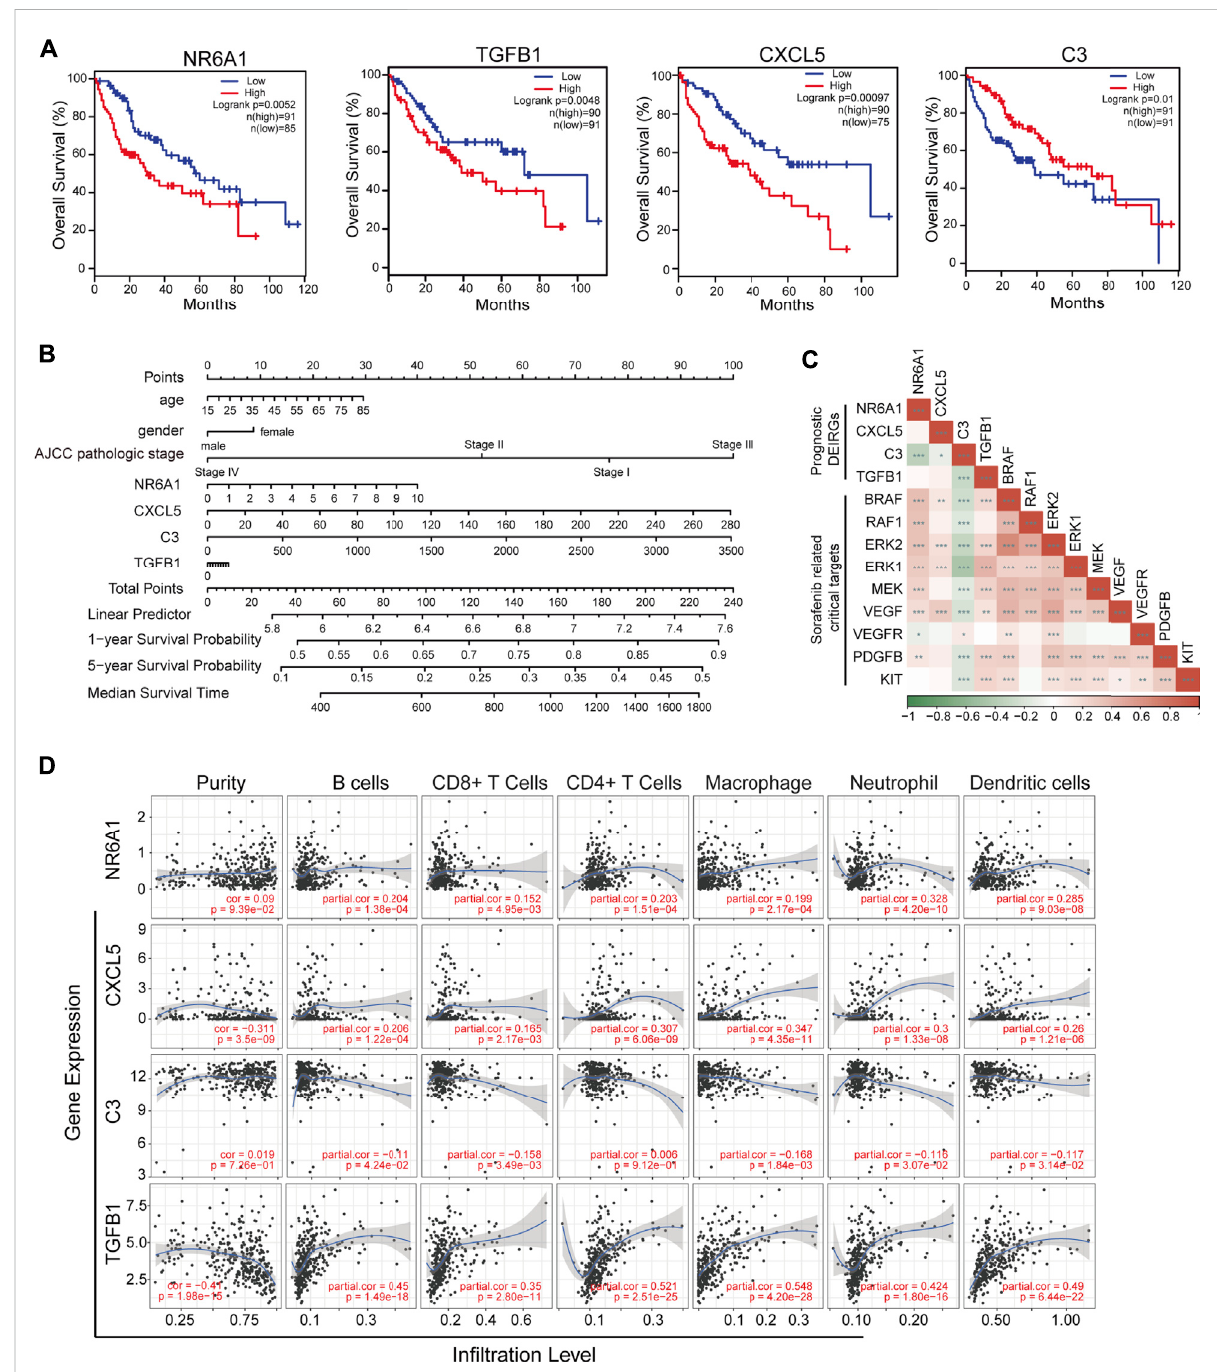
FIGURE 5 Identi fi cation of prognostic-related DEIRGs and immune cell in fi ltration. (A) Kaplan – Meier curve analysis overall survival of NR6A1, TGFB1, CXC5, and C3 in LIHC patients. (B) Nomogram model showing four independent prognostic DEIRGs and clinical risk factors in LIHC patients. (C) Heatmap ofexpressioncorrelation between thefour prognosisriskfactors andninesorafenib-related downstream targets. (D) Correlation between immune cell in fi ltration and prognostic DEIRGs in LIHC patients.